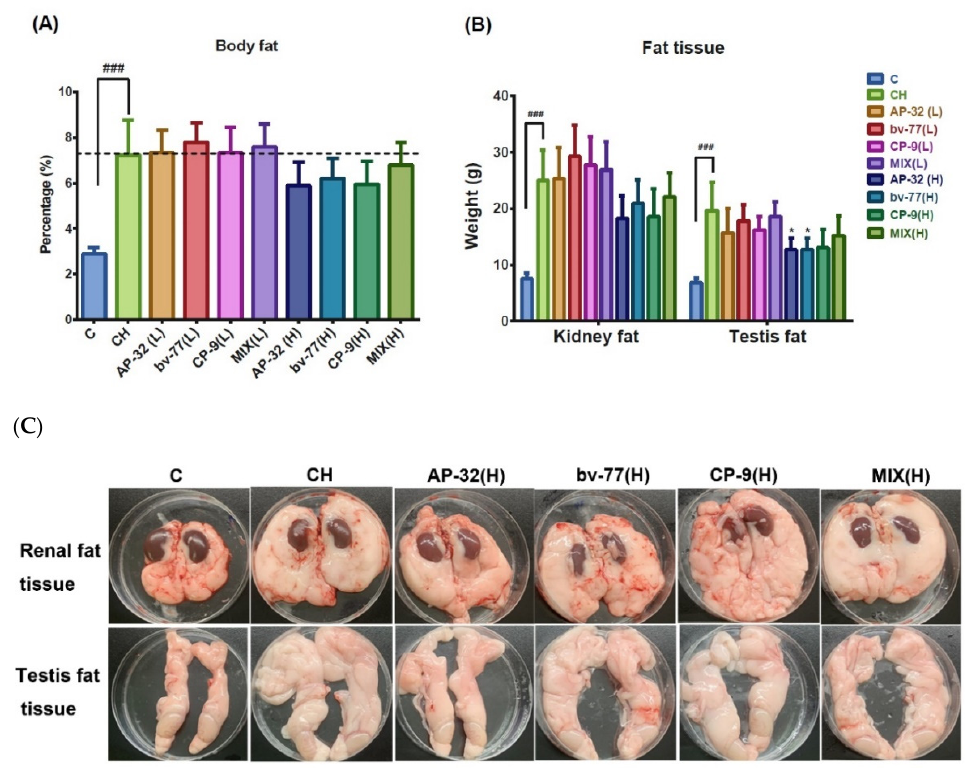
Figure 3. Analyses of body fat formation with and without probiotic treatments. After 4 weeks of probiotic treatments, rats were sacrificed at week 8. Fat tissues around the kidney and testicle were isolated and weighed. The bar graphs represent values of ( A ) the percentages of body fat to body weights or ( B ) net tissue weights of kidney fat and testis fat. ( C ) Photographs represent renal fat and testis fat in a regular-fed control rat (C), a high-fat diet obese rat (CH), and rats treated with a single probiotic strain or a mixture of three strains at the high dosage. Data are presented as the mean ± S.D. of six animals in each group. Statistical analysis was performed by using a one-way ANOVA. Statistical difference was compared between the C and CH groups (### p < 0.001) or the CH and a probiotics-treated group (* p < 0.05). C: control; CH: symptom control; MIX: probiotic mixture of AP-32, bv-77, and CP-9; L = 5 × 10 9 CFU/kg/day; H = 2.5 × 10 10 CFU/kg/day